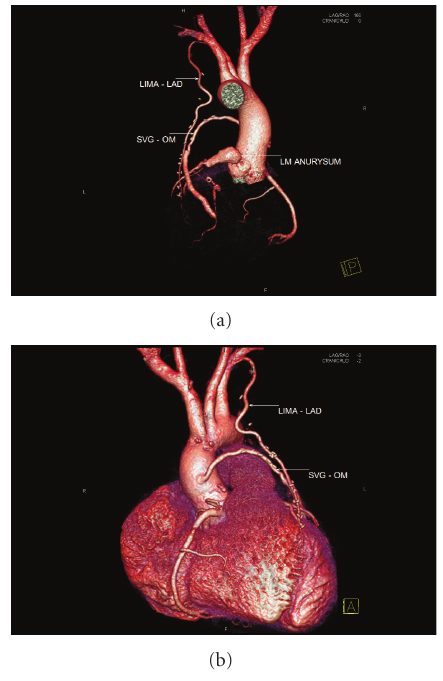
Figure 3: (a) Post-CABG CT Coronary angiogram showing proximally and distally ligated left main aneurysm with LIMA to LAD grafts and SVG to OM grafts. (b) Post-CABG CT Coronary angiogram showing proximally and distally ligated left main aneurysm with LIMA to LAD grafts and SVG to OM